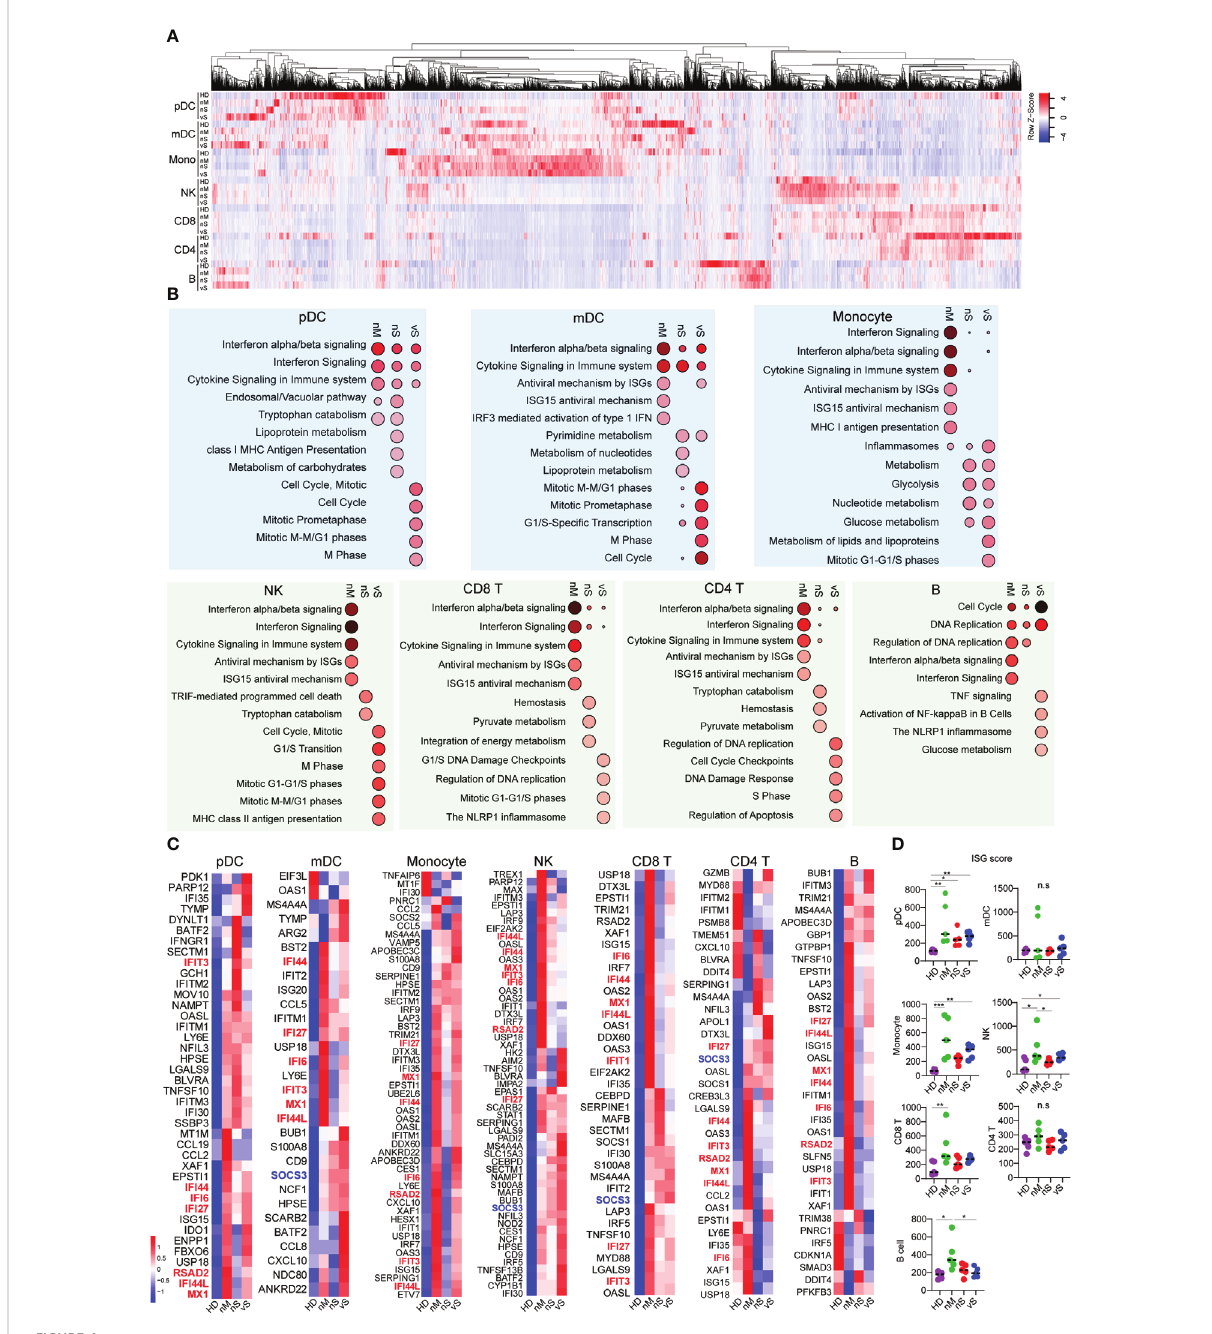
FIGURE 4 Interferon stimulated genes correlated with disease severity. (A) Heatmap re fl ecting expression intensity of a known gene list of interferon- stimulated genes (ISGs) downloaded from Interferome v2.01 during in vivo SARS-CoV-2 infection in different disease cohorts. (B) Top 10 enriched Reactome pathways, analyzing by NetworkAnalyst, identi fi ed in each cell type when compared with healthy control. The bubble size indicates the gene enrichment ratio of a biological process GO term, with color maps re fl ecting the FDR value (p. adjust) of the enrichment analysis. (C) Heatmap showing the expression of antiviral ISGs that are signi fi cantly different in COVID-19 conditions from healthy controls, ordered by hierarchical clustering. Upregulated genes are shown in red, and down-regulated genes are shown in blue. (D) ISG score was calculated based on the expression of six genes (IFI44L, IFI27, RSAD2, SIGLEC1, IFIT1, and ISG15) based on TPM transcripts. A p-value was calculated by the Kruskal-Wallis test. *p < 0.05, **p < 0.01, ***p < 0.001; n.s., not signi fi